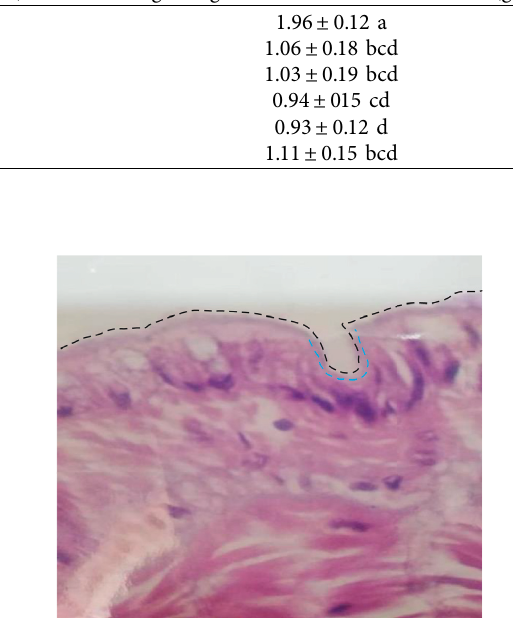
Table 2: The average weights of worms in grams, which are exposed to different concentrations of heavy metal salt. Concentrations Average weights of worms before treatment (grams) Average weights of worms after treatment (grams)